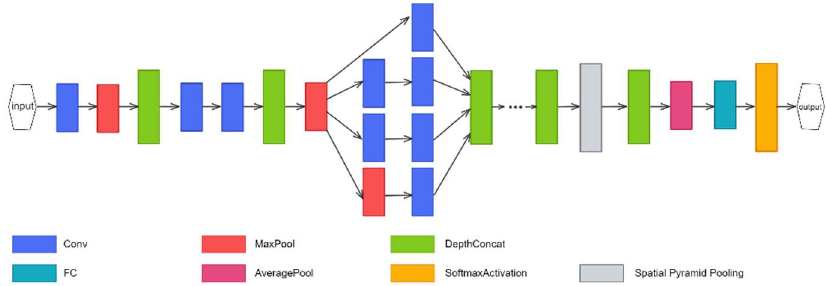
Figure 4. The model of GoogleNet + SPP. Algorithm 3 : GoogleNet + SPP Algorithm